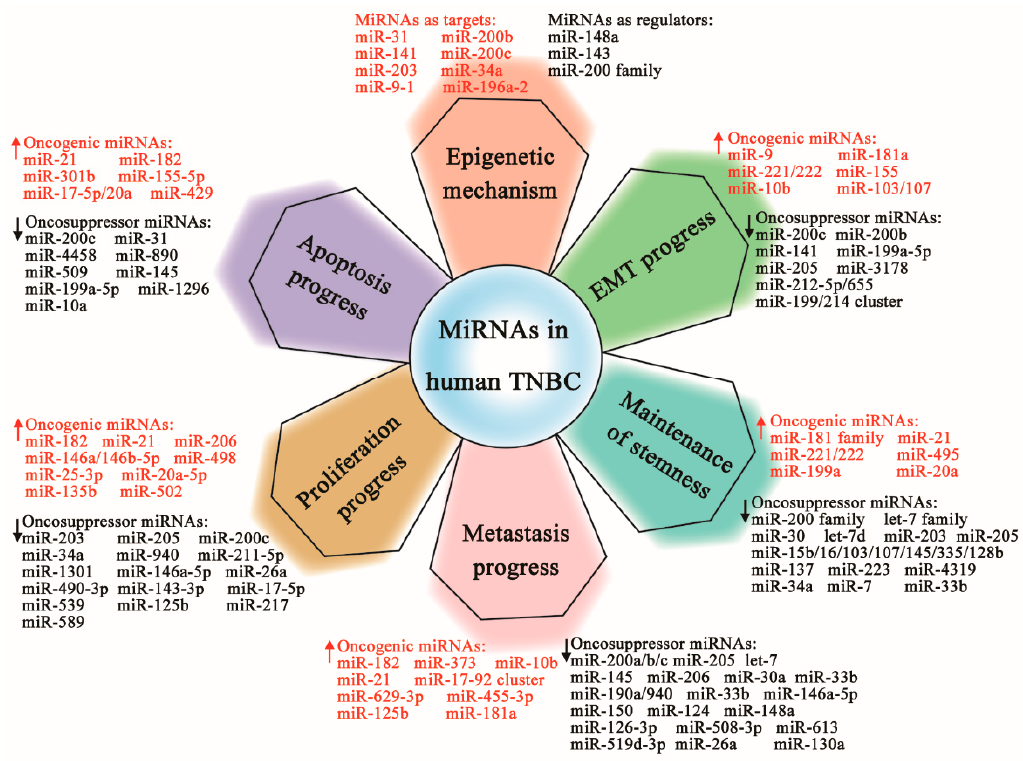
Figure 2. The multiple roles of miRNAs in TNBC. The miRNAs have a role as targets or regulators